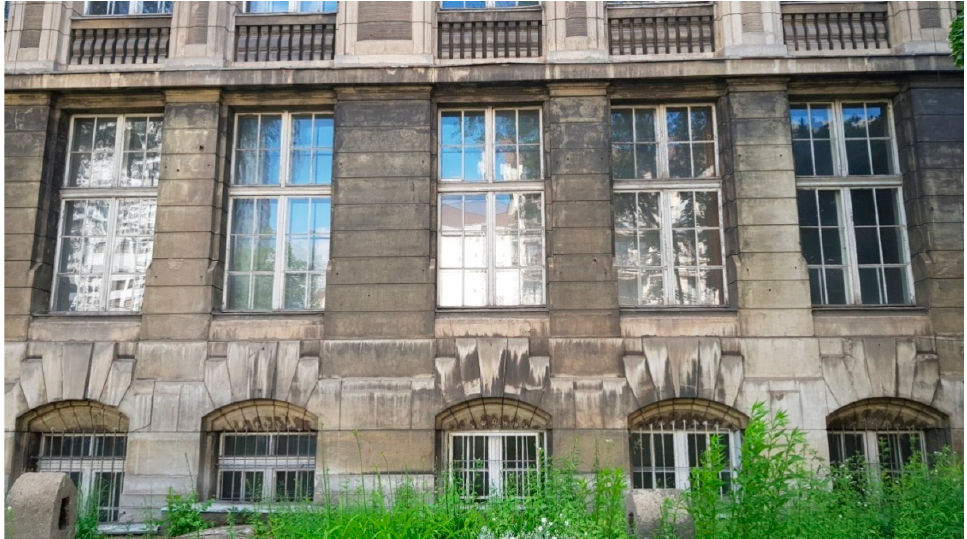
Figure 5. Part of the southern façade, with dark and black deposits visible.